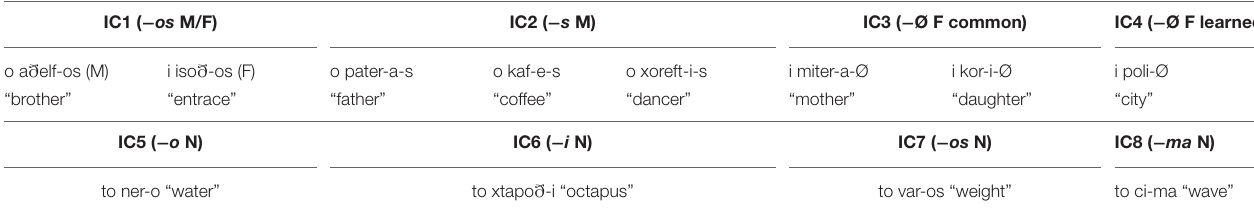
TABLE 1 | Overview of the Greek inflectional classes according to Ralli